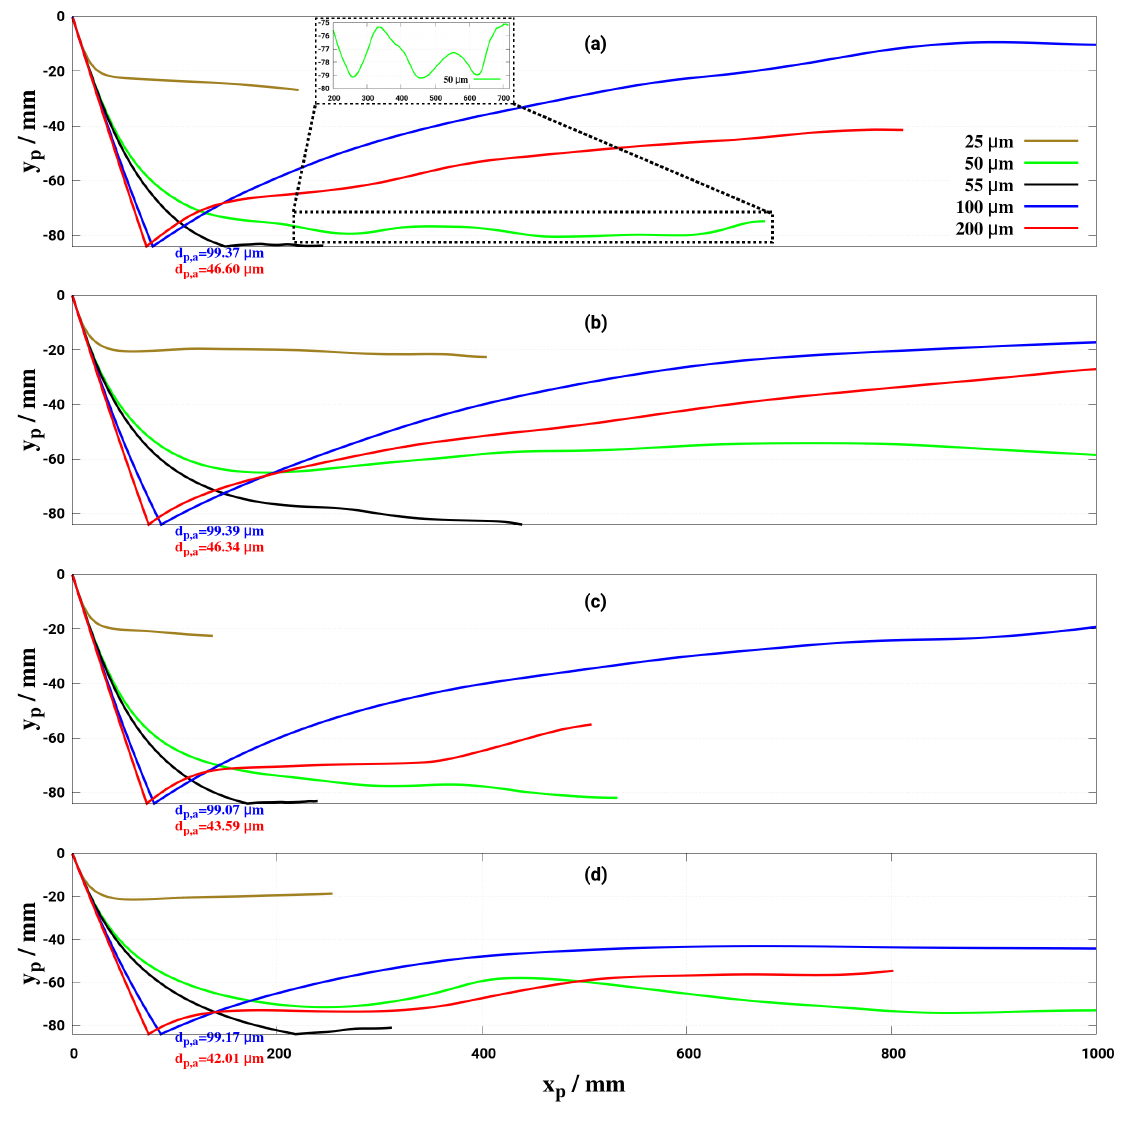
Figure 11. Droplet trajectory and life under various gas temperatures and mass flow rate cases: ( a ) T1M1; ( b ) T1M2; ( c ) T2M1; ( d ) T2M2. Initial post-impingement droplet diameters (d p,a ) are given in colors at respective impingement locations for droplets which undergo